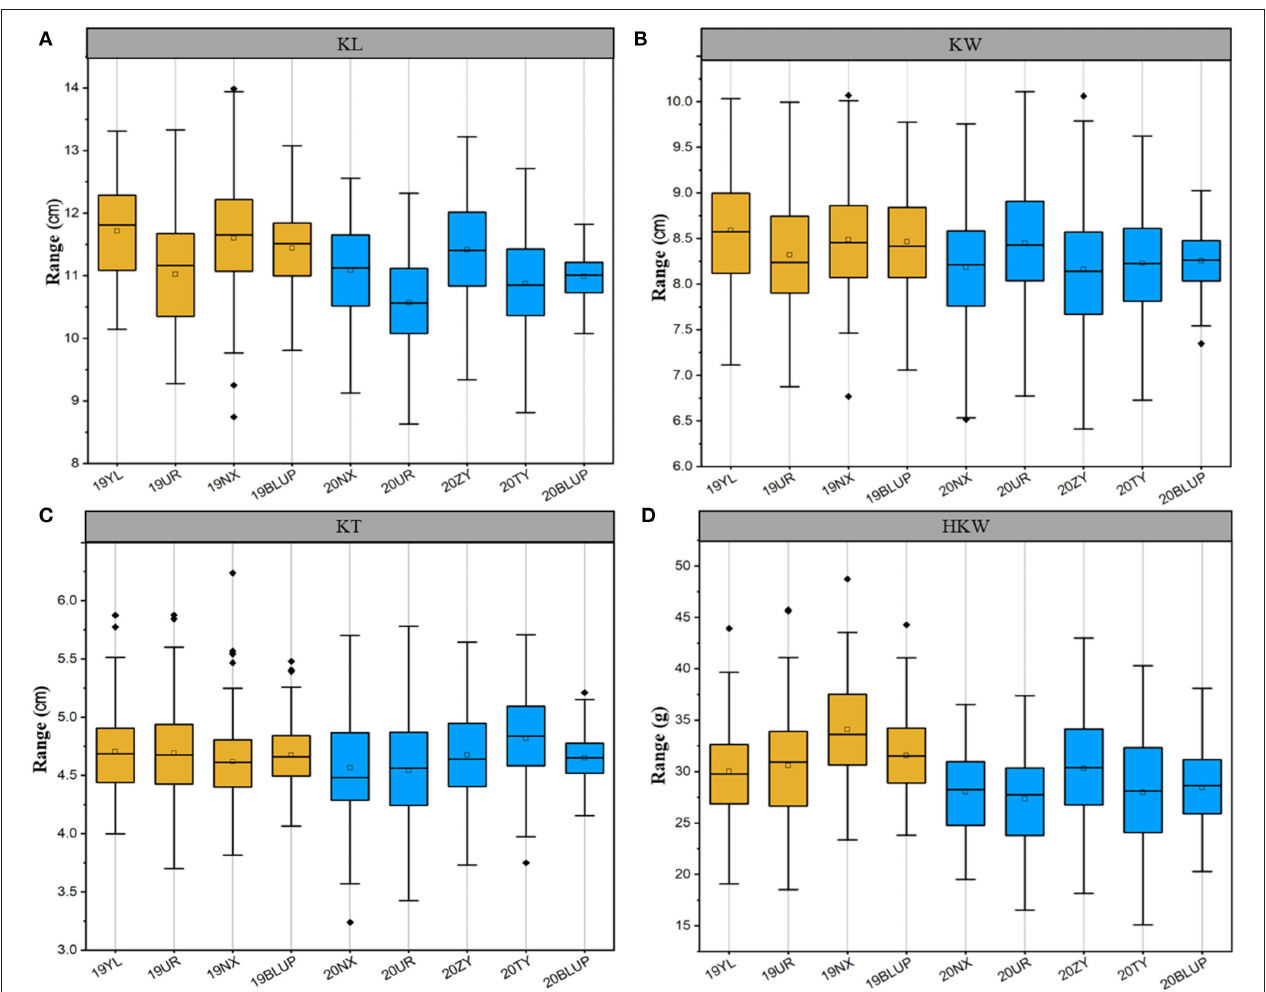
FIGURE 1 | Phenotypic distribution of the kernel-related trait in different environments. (A) KL, Kernel length; (B) KW, kernel width; (C) KT, kernel thickness; (D) HKW, hundred-kernel weight. YL, Yulin; UR, Urumqi; NX, Ningxia; ZY, Zhangye; TY, Taiyuan; BLUP, Best Linear Unbiased Prediction. Dark yellow represents the location in 2019, and blue represents the location in